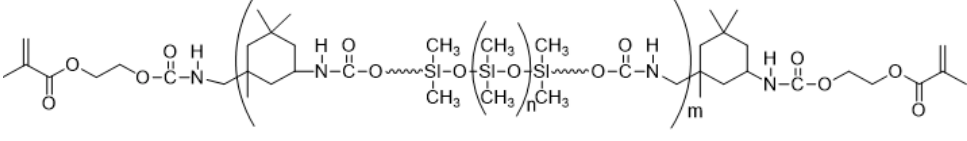
Figure 2. Chemical structure of silicone urethane dimethacrylate (SiUDMA).